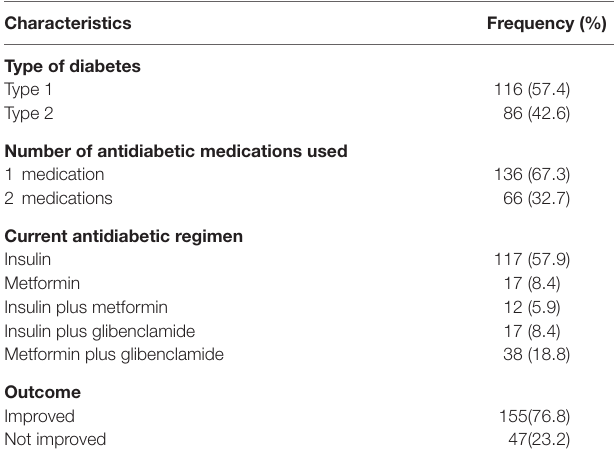
TaBle 2 | Disease and treatment characteristics of diabetic patients in University of Gondar Hospital ( N = 202).